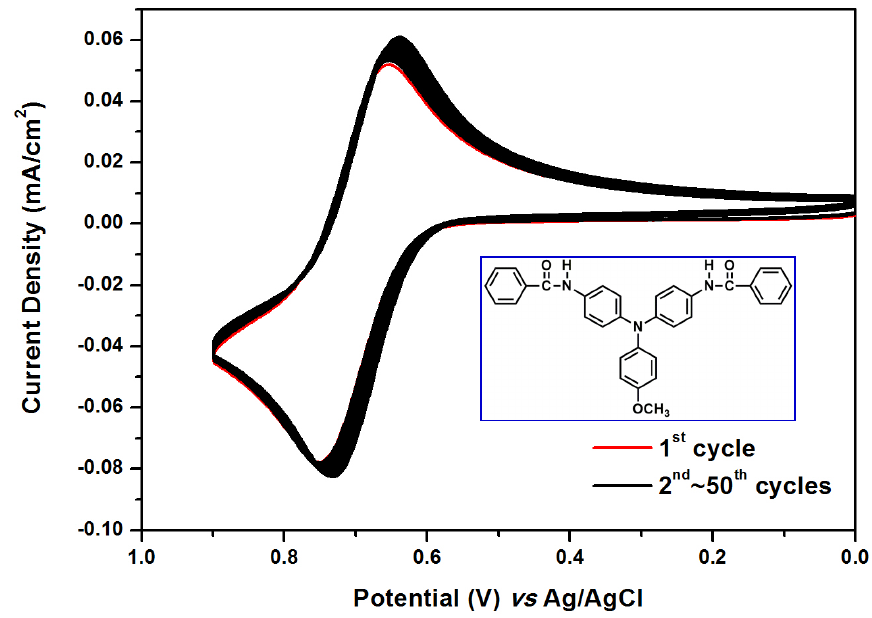
Figure 3. Repetitive cyclic voltammograms (50 cycles) of 2 × 10 −4 M model compound MeOTPA-(Ph) 2 in 0.1 M Bu 4 NClO 4 /CH 2 Cl 2 solution at a scan rate of 50 mV · s − 1 .